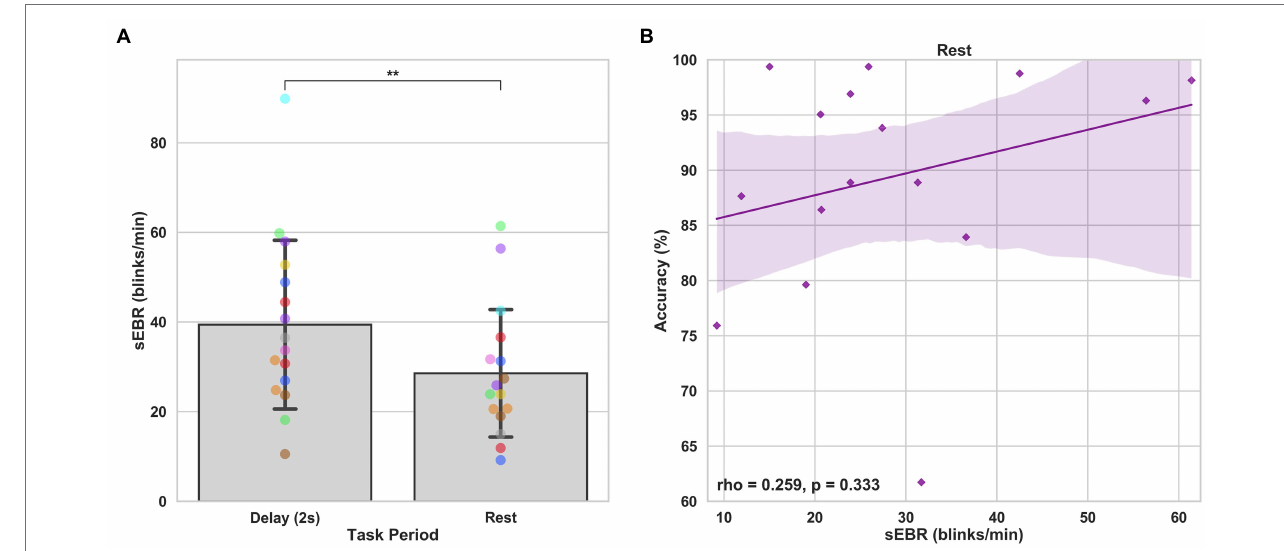
FIGURE 4 | Paired T tests between Delay period sEBR and Rest sEBR and correlation between Rest sEBR and task accuracy in Experiment 1. (A) Bar plots show task period on the x-axis and sEBR on the y-axis. Delay period sEBR was significantly higher than Rest sEBR. Error bars depict 95% confidence interval. (B) Correlation plot of sEBR during the Rest period on the x-axis and task accuracy on the y-axis. Fitted line represents linear regression model fit. Shaded region depicts 95% confidence interval. ** p <